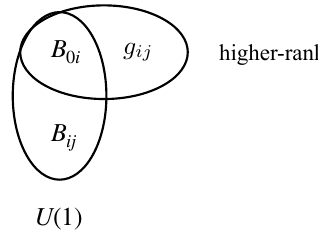
Figure 2: B is shared by two sets of gauge 0 i